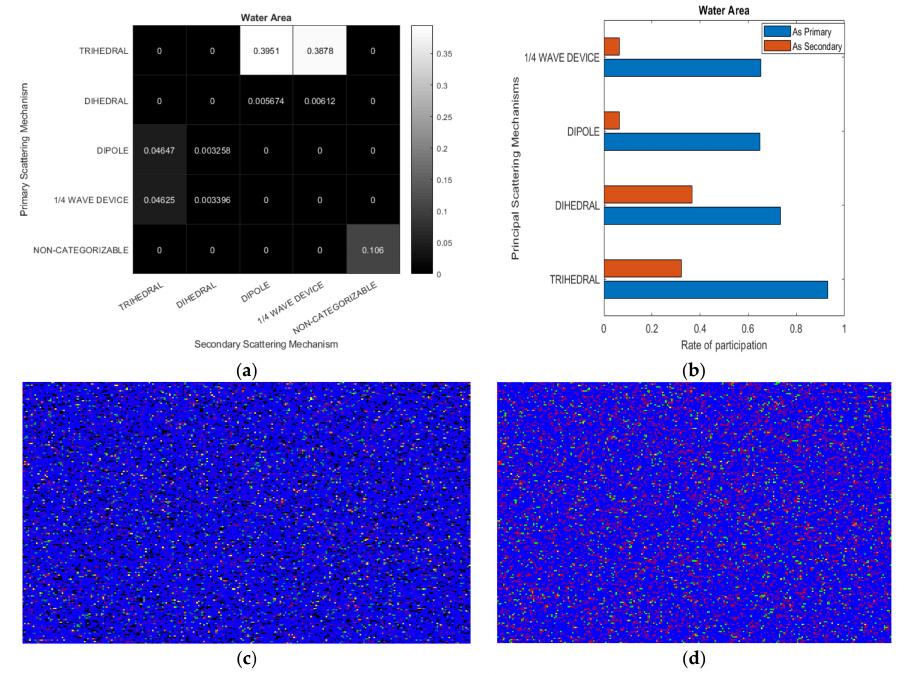
Figure 7. Heatmap ( a ) of Primary-Secondary scattering pairs and bar diagram ( b ) with the rate of contribution (strength) either as primary or secondary scatterer for each mechanism in water area. ( c ). Color Representation of each PolSAR cell using the double scatterer method. ( d ). Color Representation of each PolSAR cell using the Cameron’s CTD